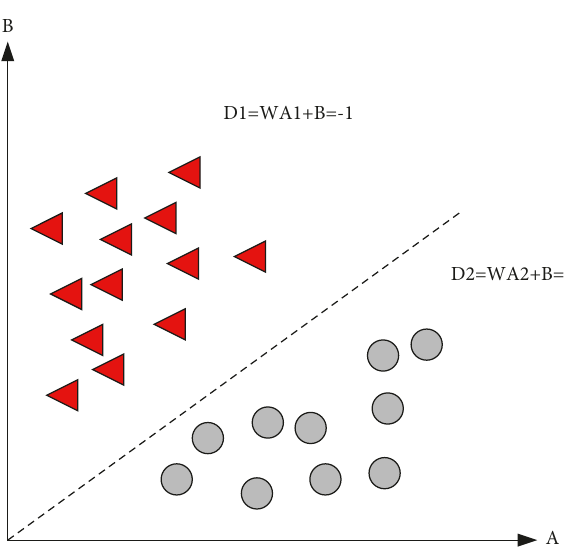
Figure 4: Support vector